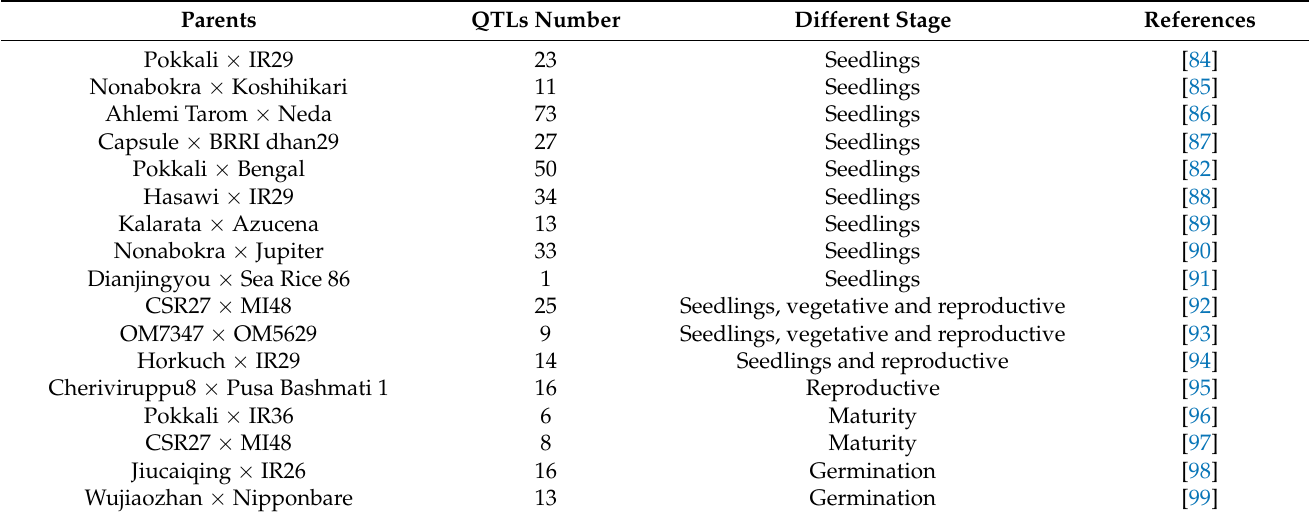
Table 1. Rice QTLs linked to salt